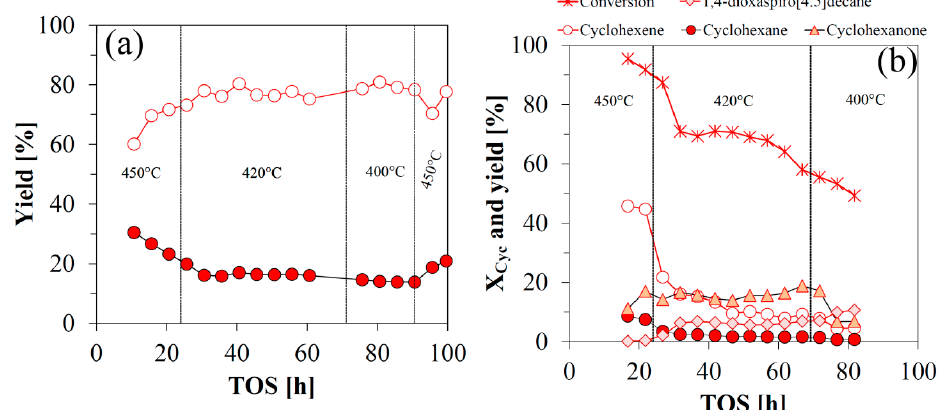
Figure 7. Carbon based product yields from the conversion of ( a ) pure cyclohexanol (Cyc); and ( b ) a cyclohexanol / ethylene glycol mixture (Cyc / EG). Based on cyclohexanol. The conversion of cyclohexanol for the pure compound ( a ) was ≥ 99.5% during the entire time on stream and is therefore not shown. Set point temperatures are shown.